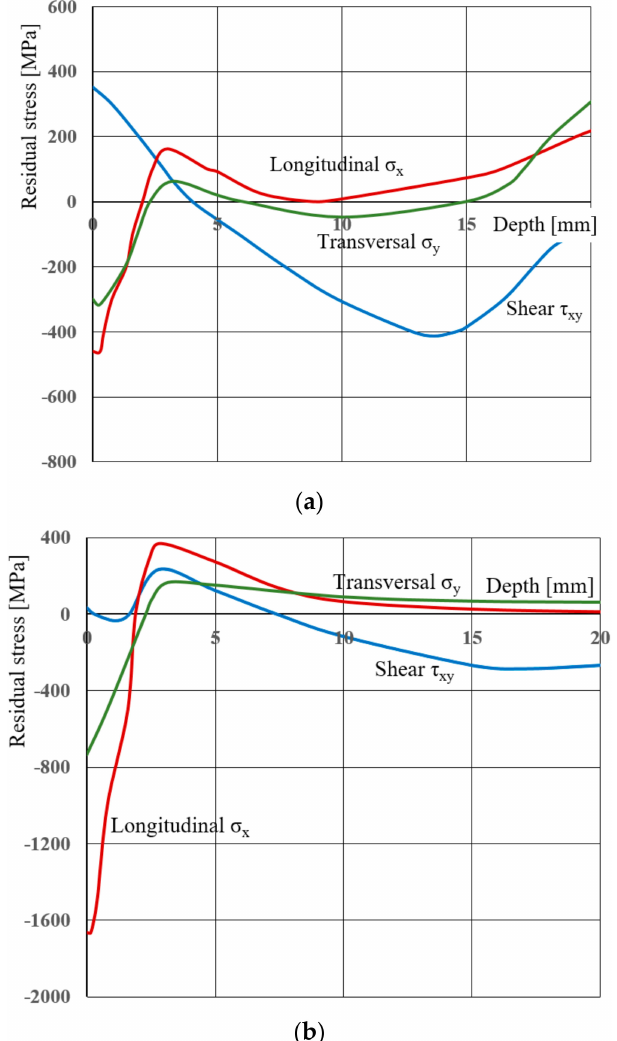
Figure 2. Residual stress components after surface rolling and presetting [3]: ( a ) Technology A and ( b ) Technology